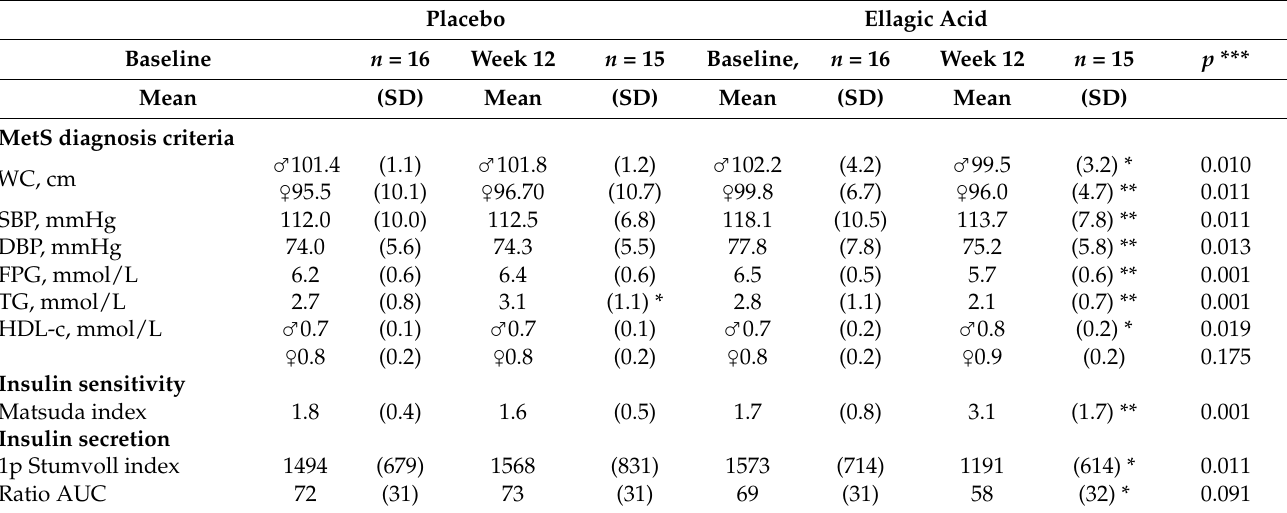
Table 2. Primary outcomes at baseline and at the end of the